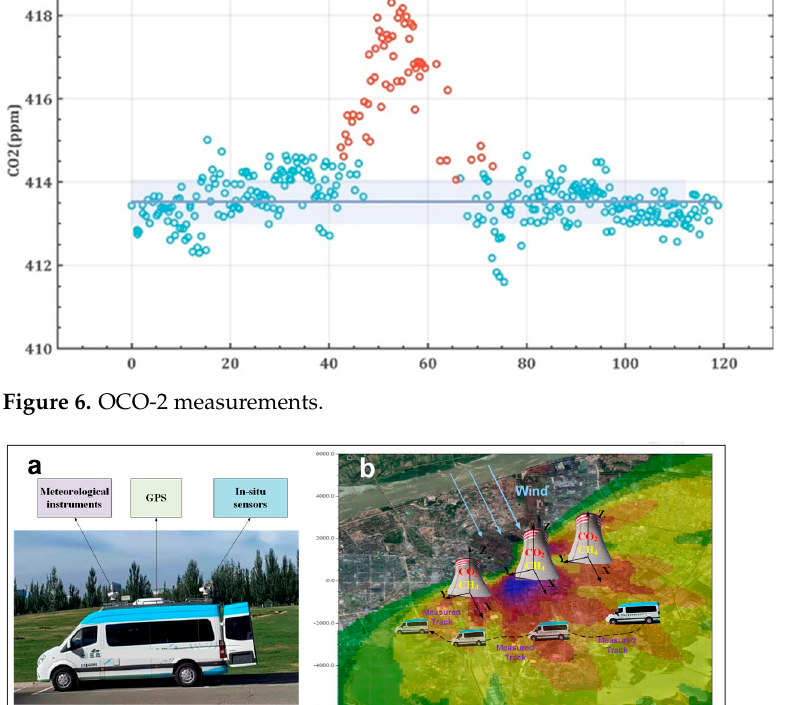
Figure 7. Mobile system measurements. ( a ) is the schematic diagram of the mobile system, ( b ) is the schematic diagram of the measuring trajectory.